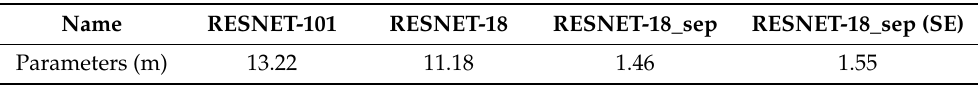
Figure 3. The standard residual block of the raw RESNET-18 is on the left and the basic residual block of the proposed RESNET-18 is on the right. Table 1. The comparison of the parameters number among the different networks. The depthwise separable convolution is used in the RESNET-18_sep. The depthwise separable convolution and the SE are applied in the RESNET-18_sep (SE).